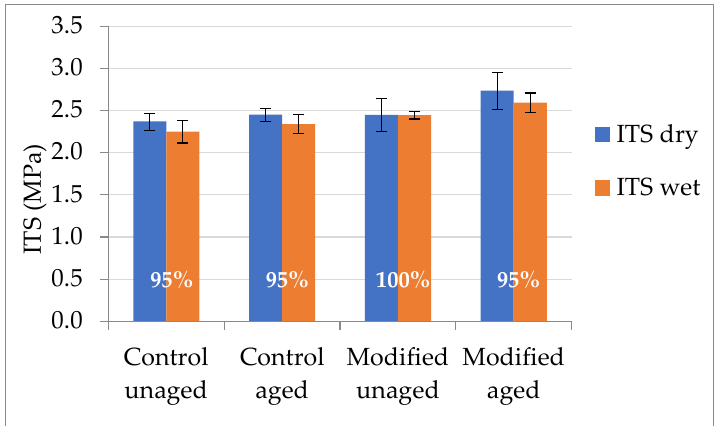
Figure 2. ITS and ITSR of the control and modified SMA 8 in unaged and aged conditions.